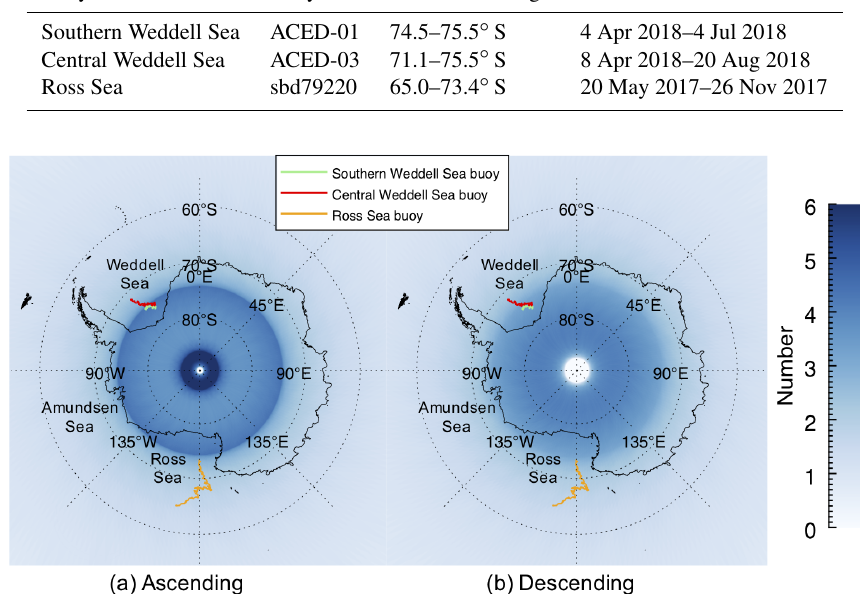
Figure 2. Mean daily number of AMSR2 swaths for (a) ASC and (b) DES passes. Trajectories of three buoys used in this study are also